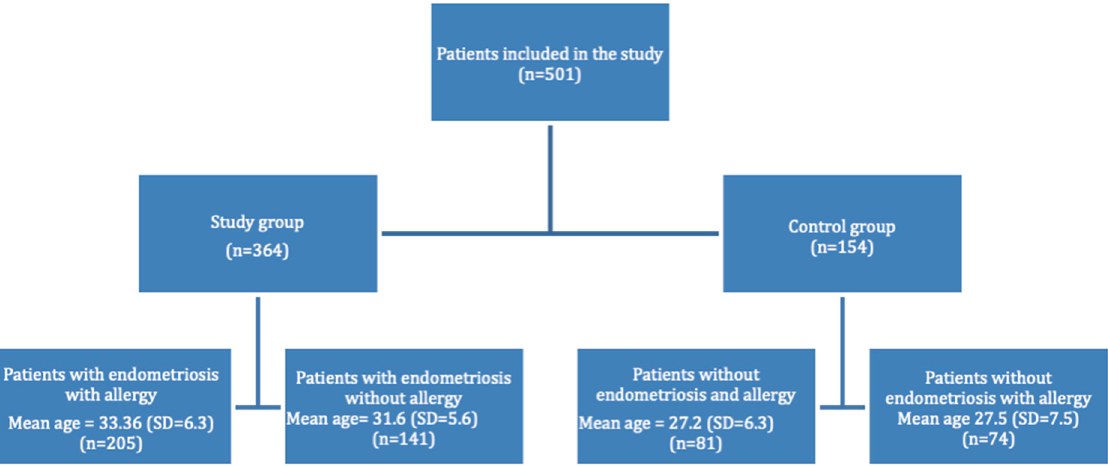
Figure 1. Distribution of patients between the groups in the study (SD—standard deviation, n—number).